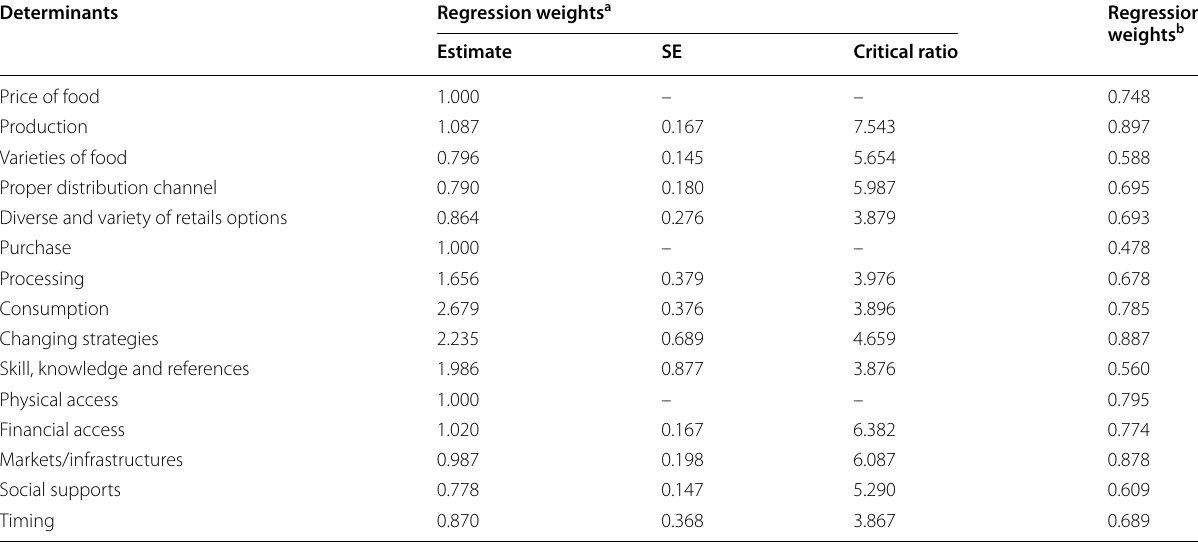
Table 3 A statistical representation of Confirmatory factor